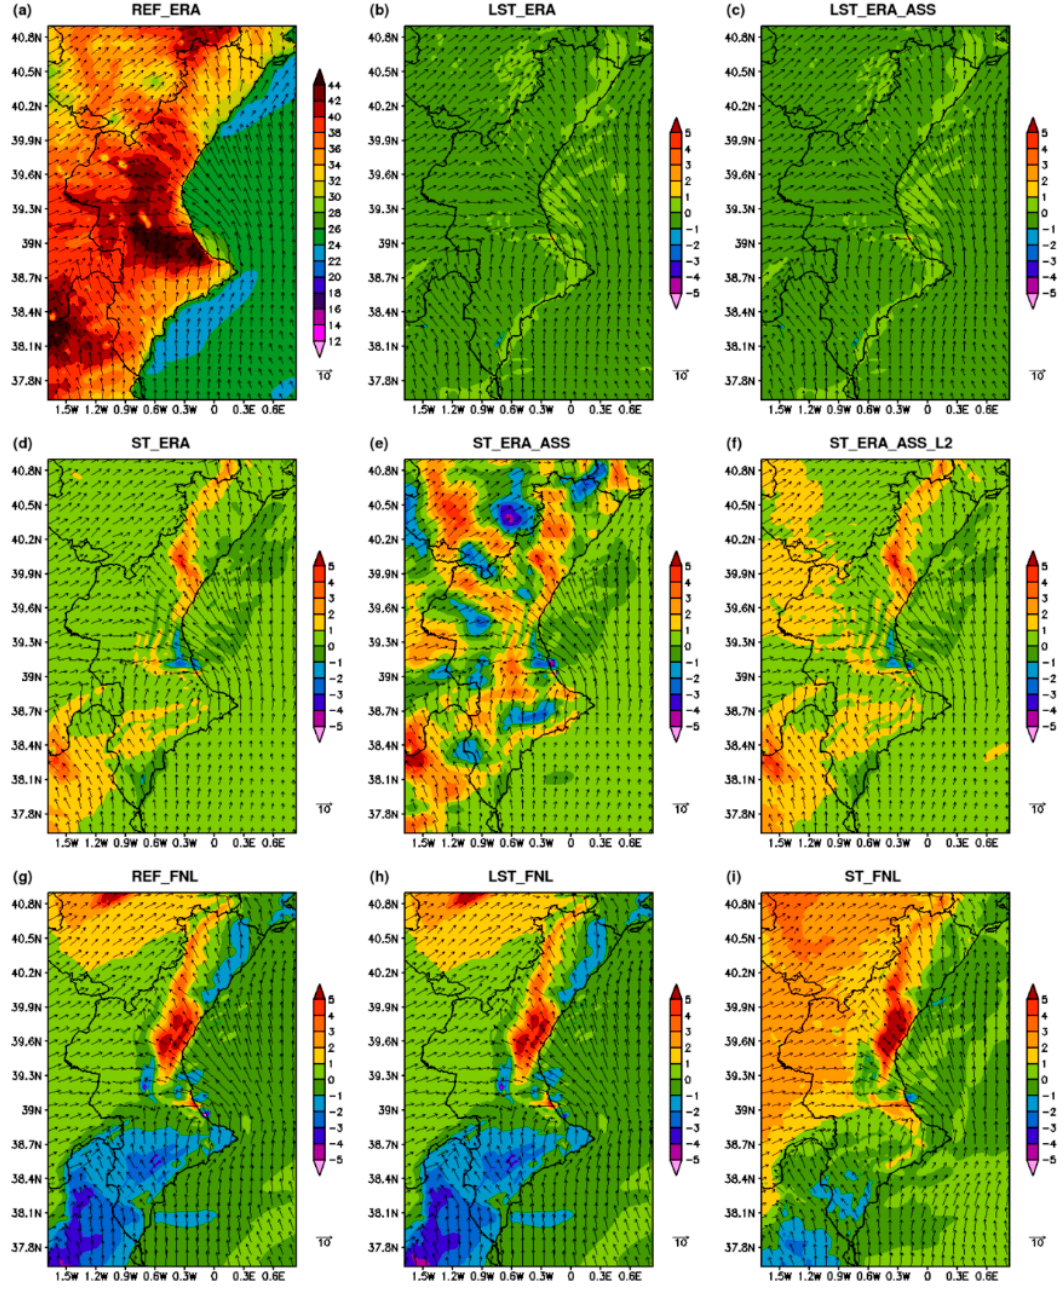
Figure 4. Forecasted 2-m maximum temperature (°C) and near-surface wind field (m/s) at 15 UTC on 22 July 2009, considering the control RAMS simulation (REF_ERA, a ) and the difference of this simulation and the corresponding sensitivity test, LST_ERA ( b ); LST_ERA_ASS ( c ); ST_ERA ( d ); ST_ERA_ASS ( e ); ST_ERA_ASS_L2 ( f ); REF_FNL ( g ); LST_FNL ( h ) and ST_FNL ( i ).